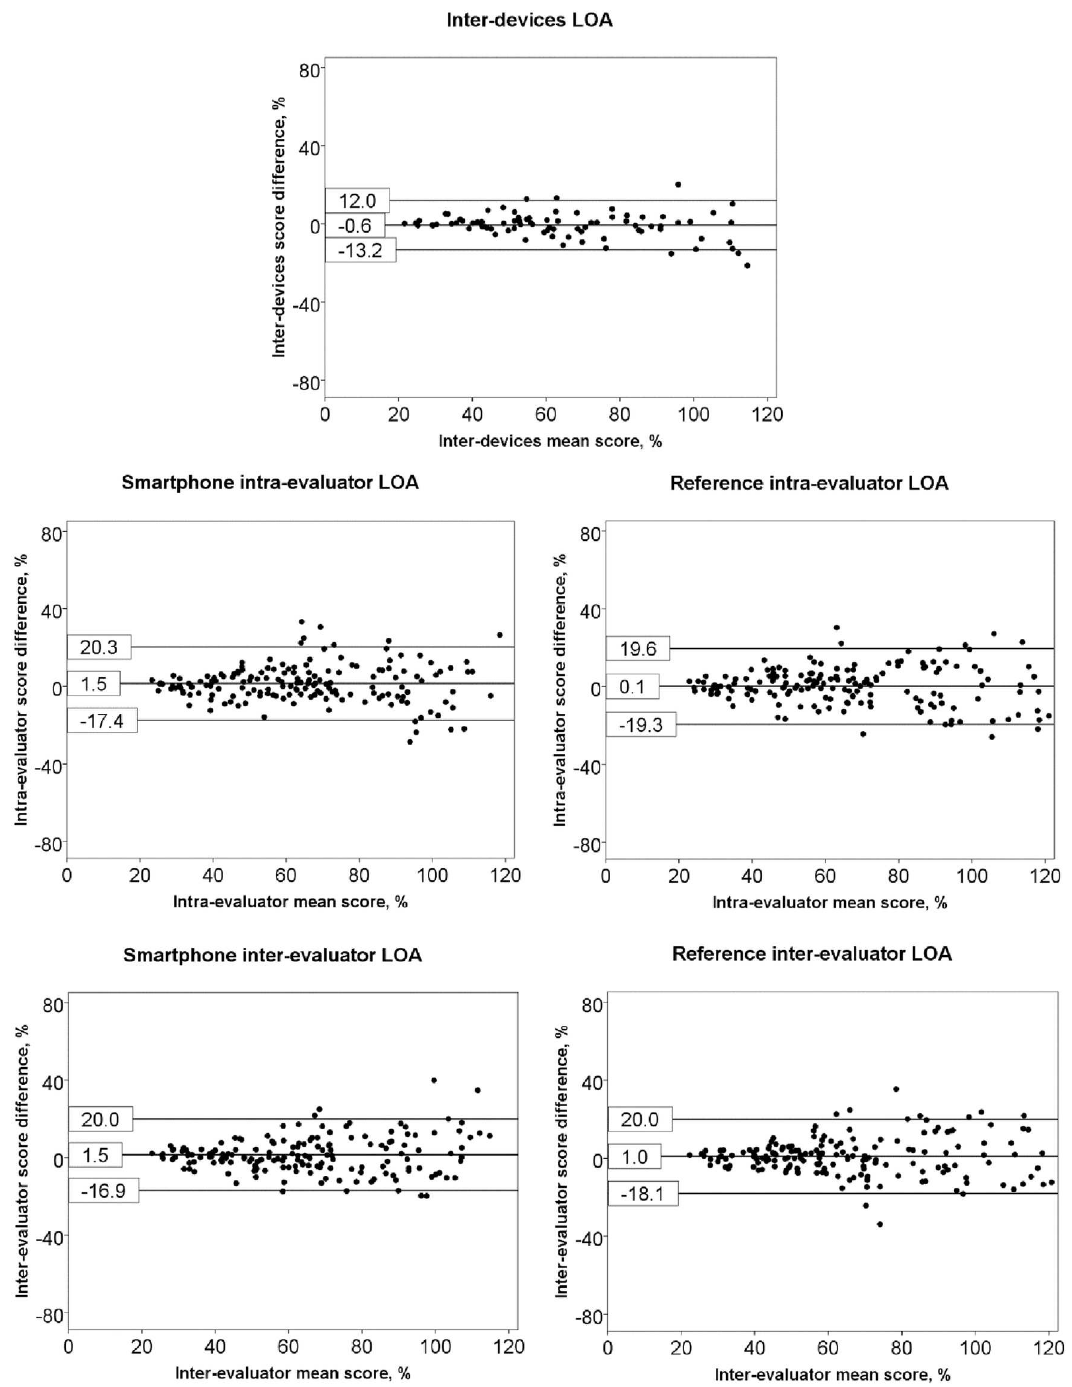
Fig 4. Bland and Altman graphs for inter-devices, intra- and inter-evaluator limits of agreement. Legend: LOA: limits of